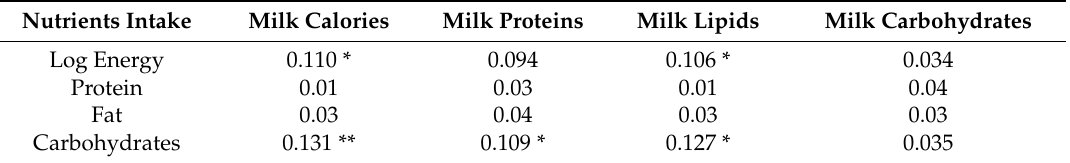
Table 1. Linear regression between mothers’ food intake and milk composition (coefficient r).